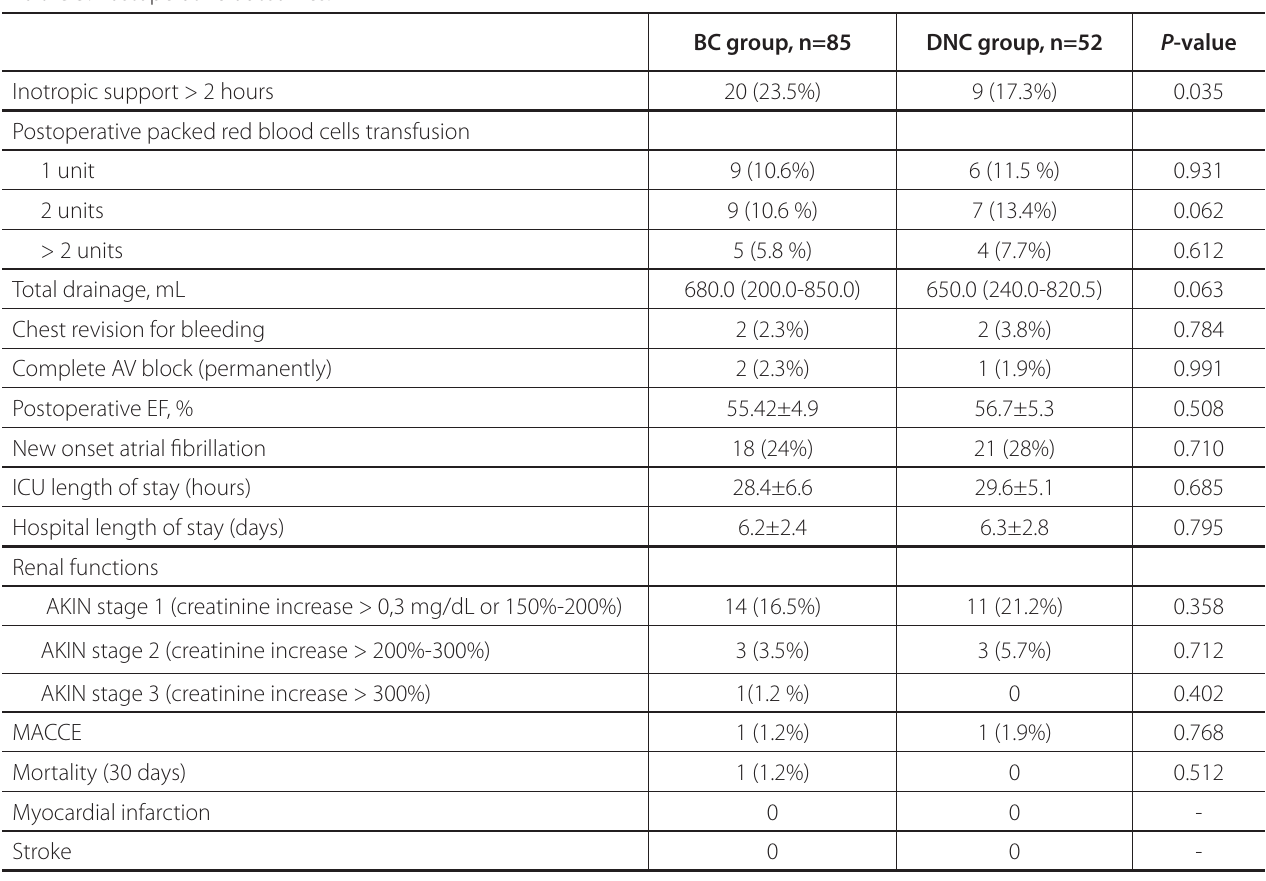
Table 3 . Postoperative outcomes.